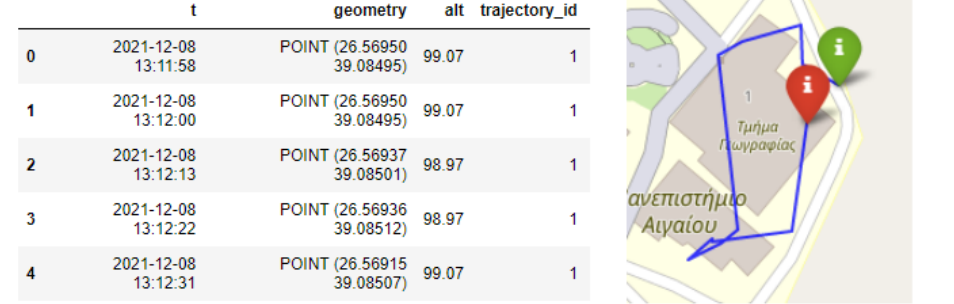
Figure 9. Weather data obtained using open Web services.